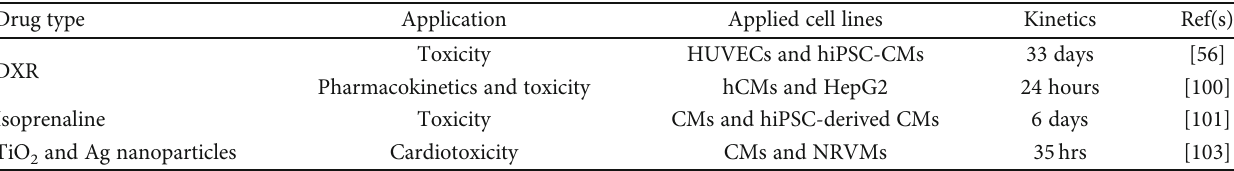
Table 5: Summary of recent advancements in cardiotoxicity modelling and testing including the type of drug, the application, the applied cell lines, and the